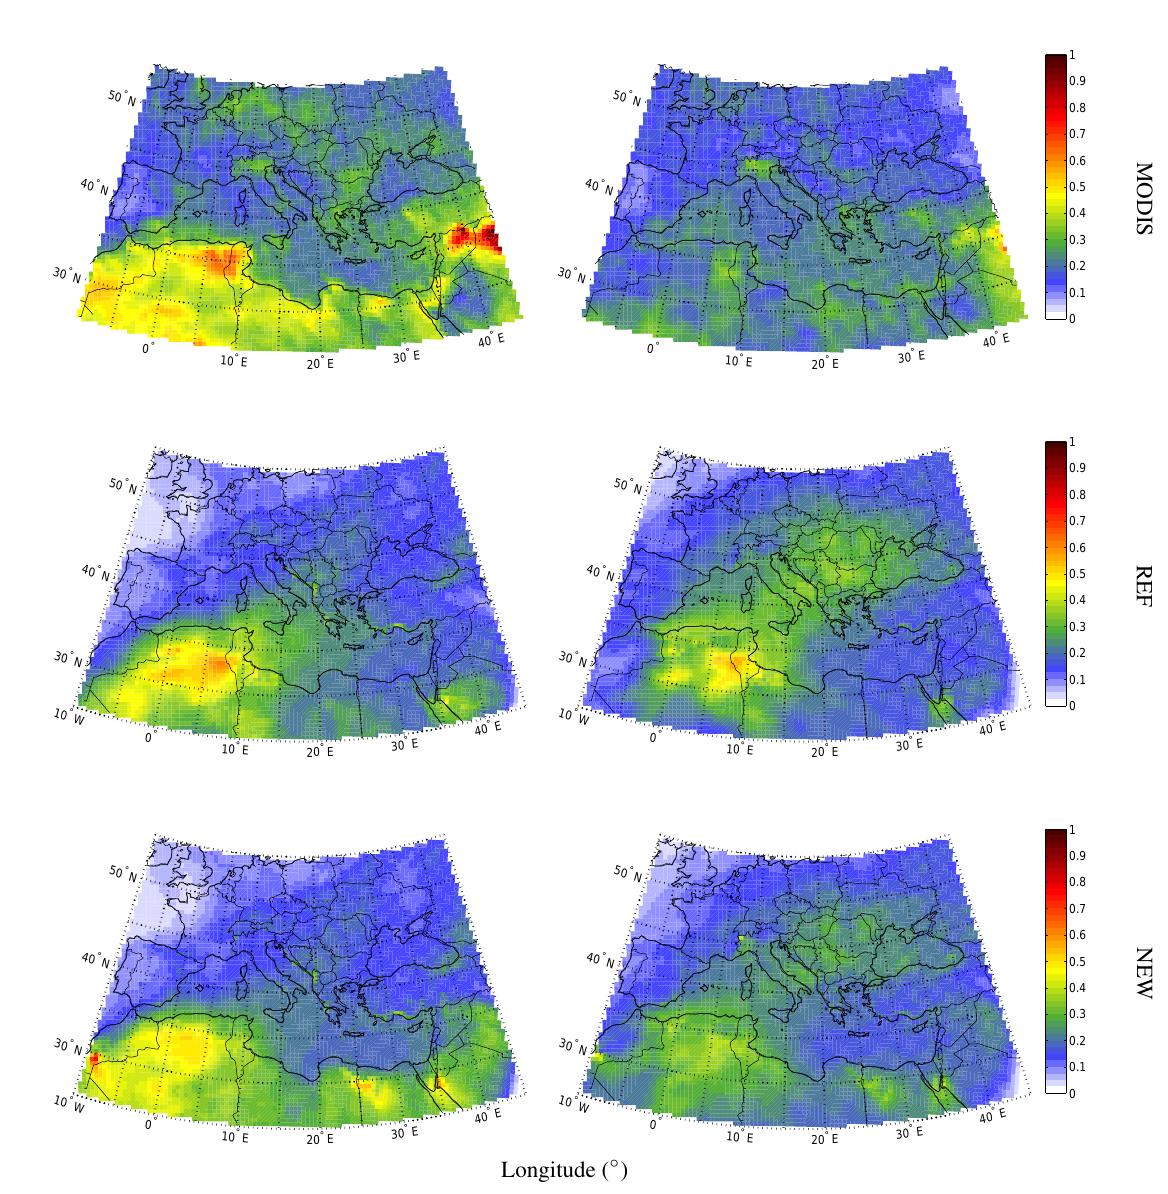
Fig. 10. Comparison of aerosol optical depth (AOD) at 550nm between MODIS data (top panels), REF-experiment (middle panels) and NEW-experiment (bottom panels) in summer (June–July–August) 2008 (on the left) and in autumn (September–October–November) 2008 (on the